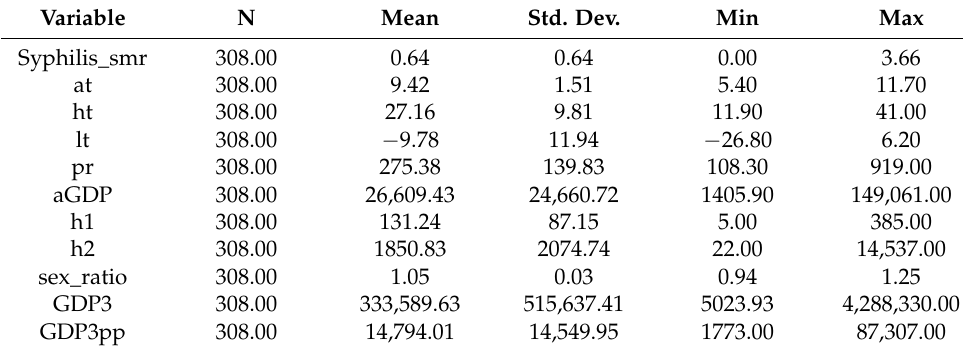
Table 3. Descriptive statistics of the study variables.